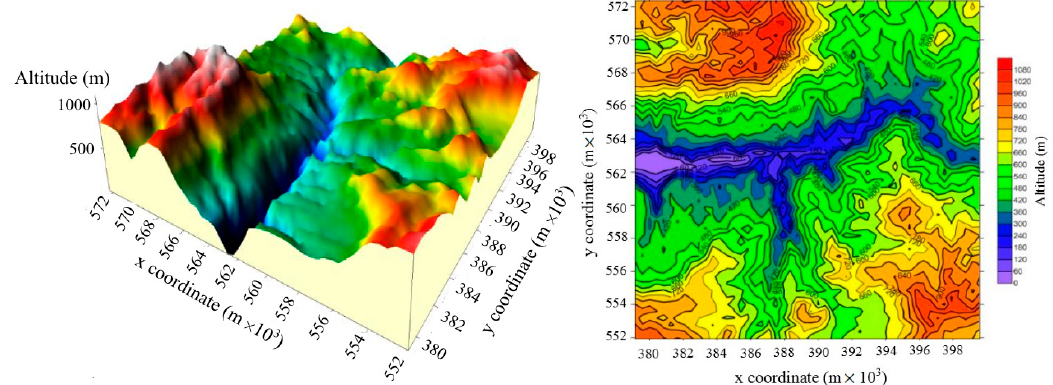
Figure 1. Topography of the wind farm in the study site (Um Al Rumman, Jordan) as seen from south-west 3D ( left ) and 2D ( right ).